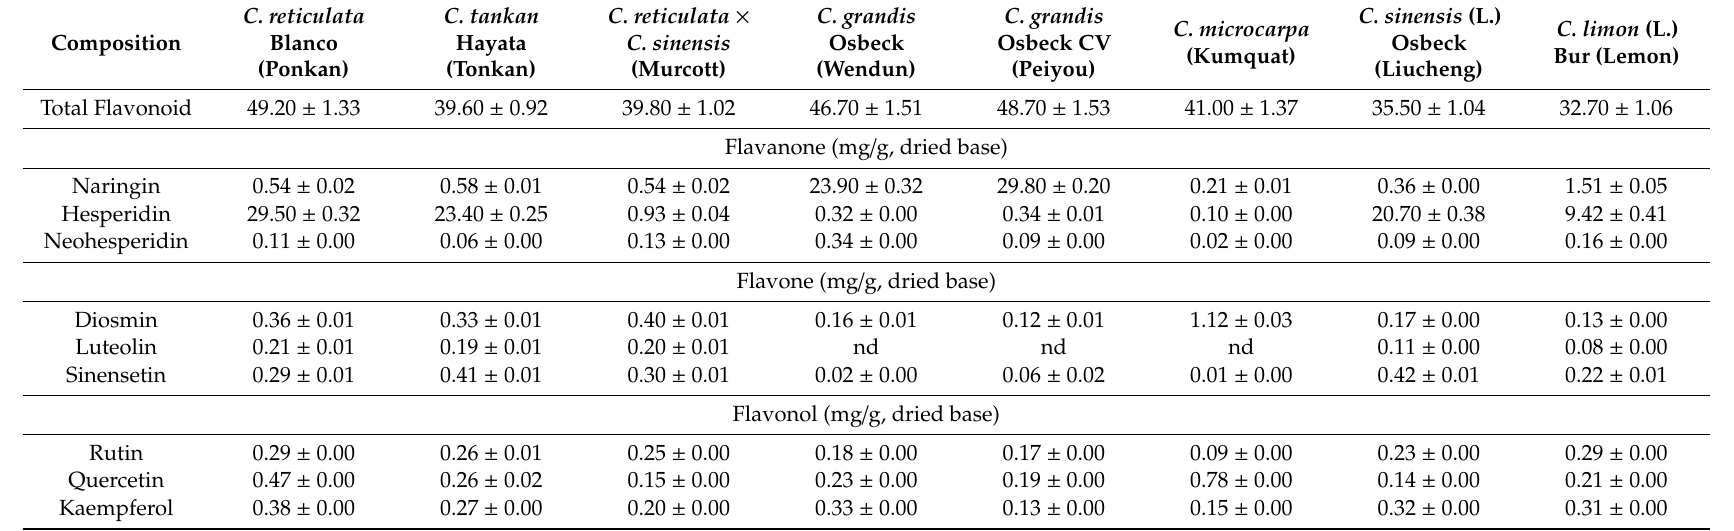
Table 4. Composition of major flavonoids determined from methanolic extraction of peels of di ff erent citrus fruits cultivated in Taiwan